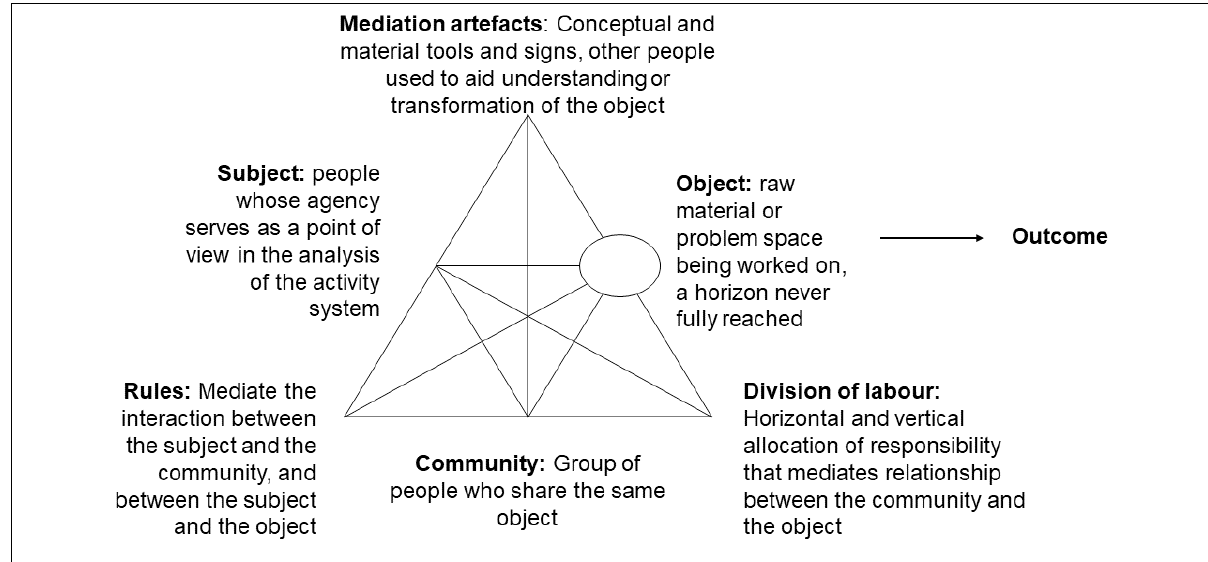
Figure 1: Elements of a contextualised second-generation activity system (adapted with permission from Engeström 7